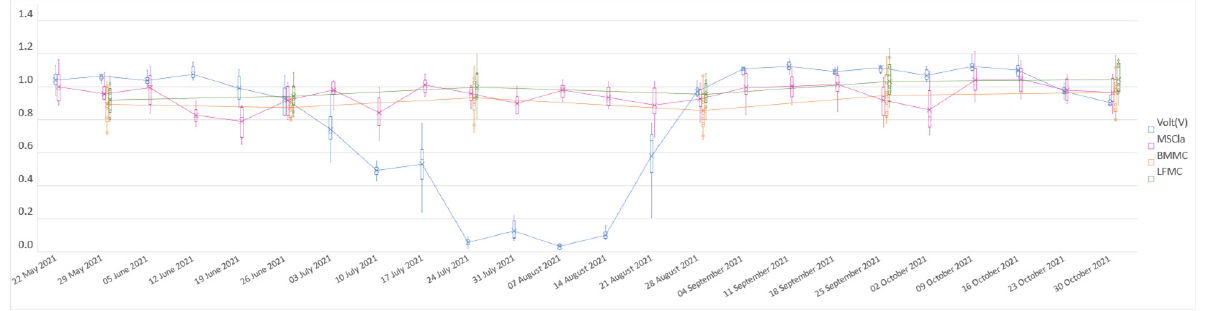
Figure 5. Seasonal variability of moisture content of the first living branch (BBMC%, BMMC% and LFMC%) in comparison with voltage during the 24 weeks from late spring to early autumn 2021.